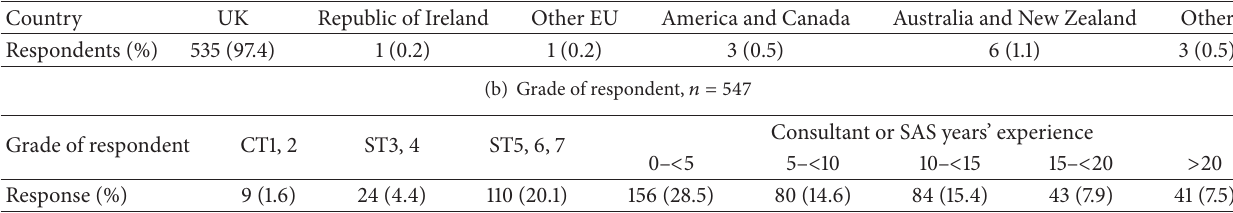
Table 1: Demographic data of Survey II.